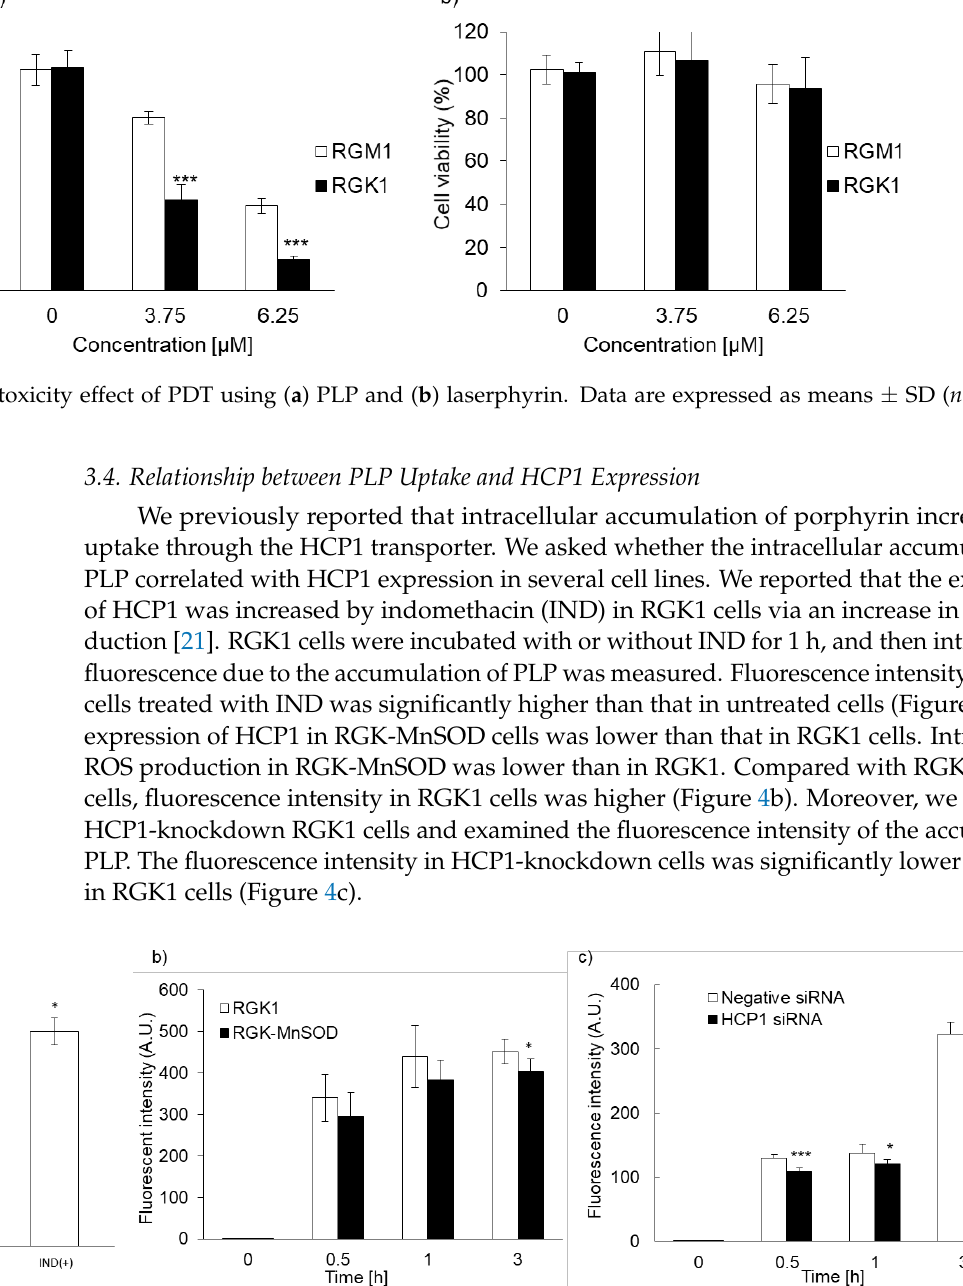
Figure 2. Intracellular PLP accumulation. Microscopy images of RGK1 ( a ) and RGM1 ( b ). Intracellular fluorescence inten- sity of PLP was measured using a microplate reader ( c ). Data are expressed as means ± SD ( n = 5). * p < 0.05, ** p < 0.01.